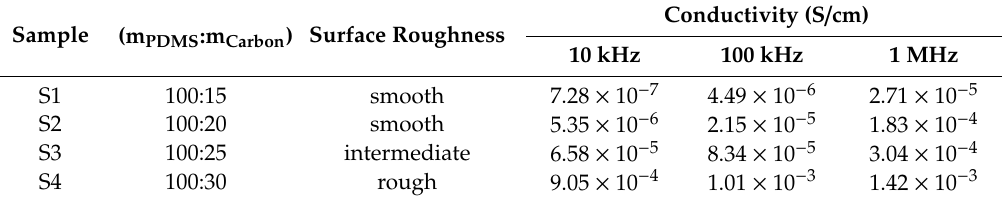
Figure A1. The reciprocating strain cycle tensile testing machine prepared by the investigators for durability testing. The flexible sensors are clamped at both ends to the machine. Required elongation and strain frequency are set with computer software, which controls a cyclic stepper motor. Table A1. Effect of carbon black addition on PDMS conductivity.